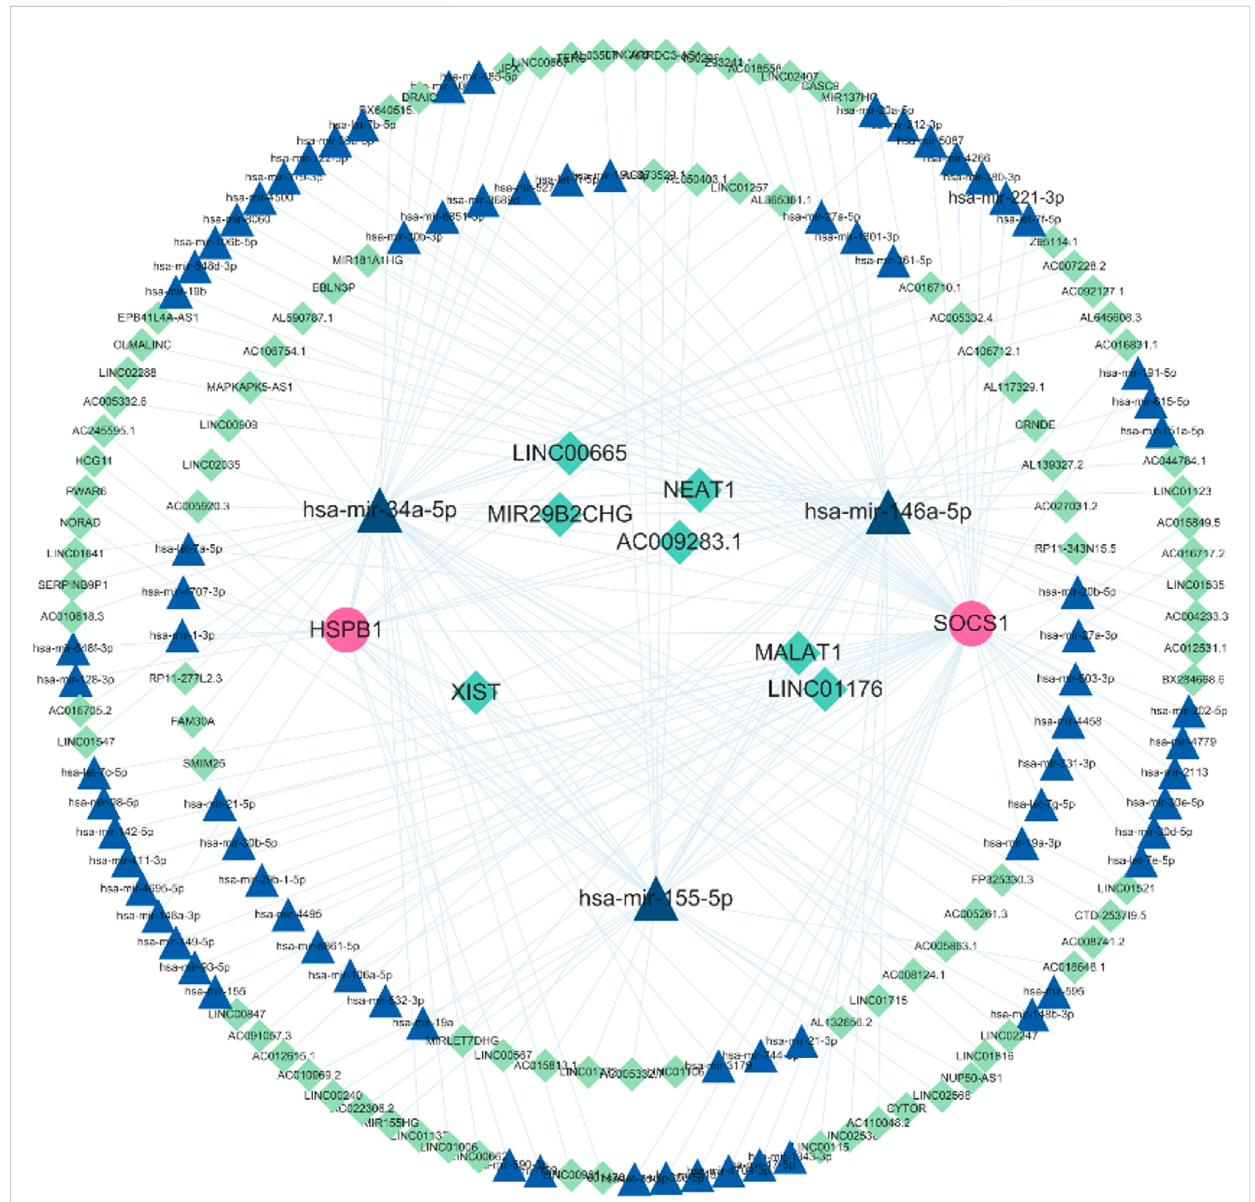
FIGURE 7 The ceRNA network. The ceRNA network was constructed through Cytoscape software. Triangles represent miRNAs, circles represent biomarkers, and lozenges represent